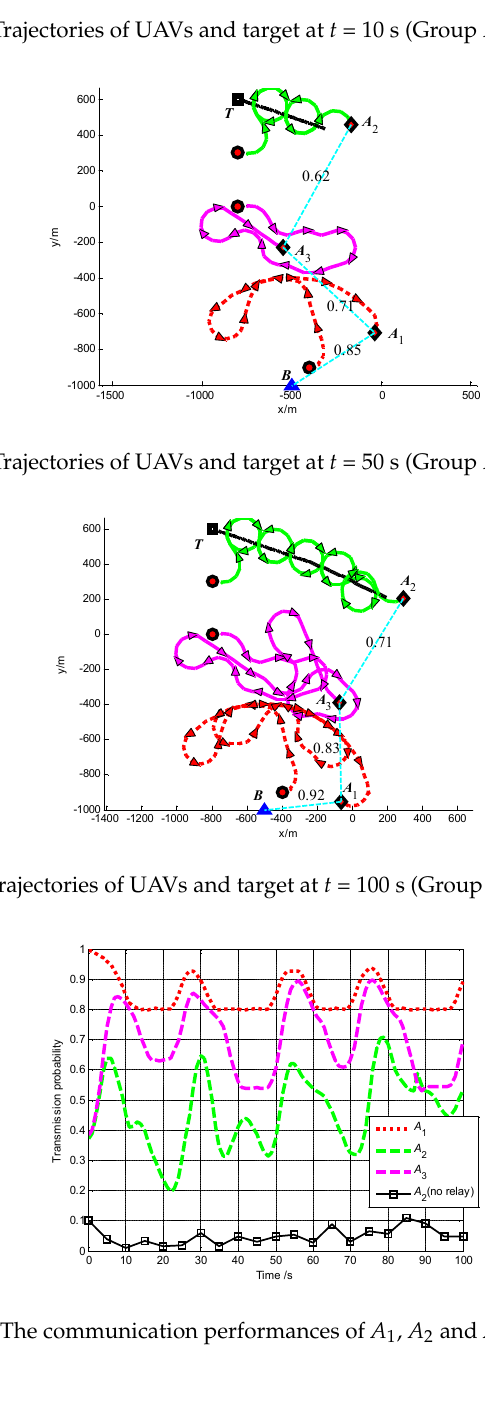
1 , A 2 and A 3 (Scenario